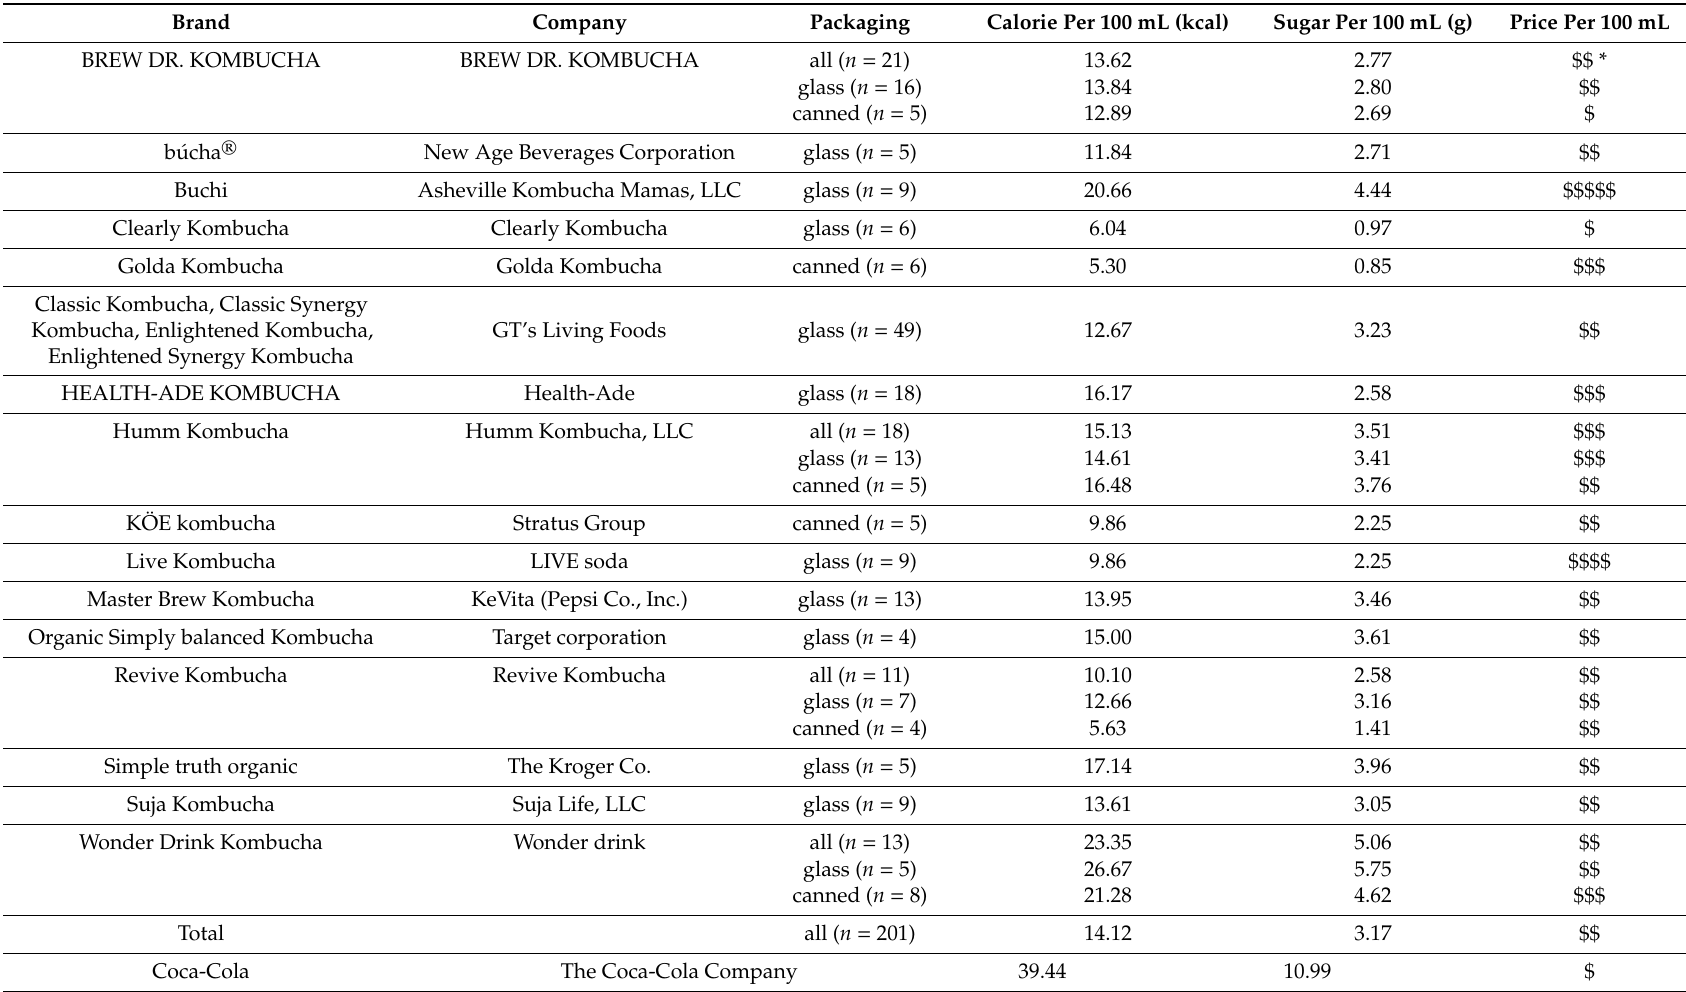
Table 7. Details of commercial kombucha products in the